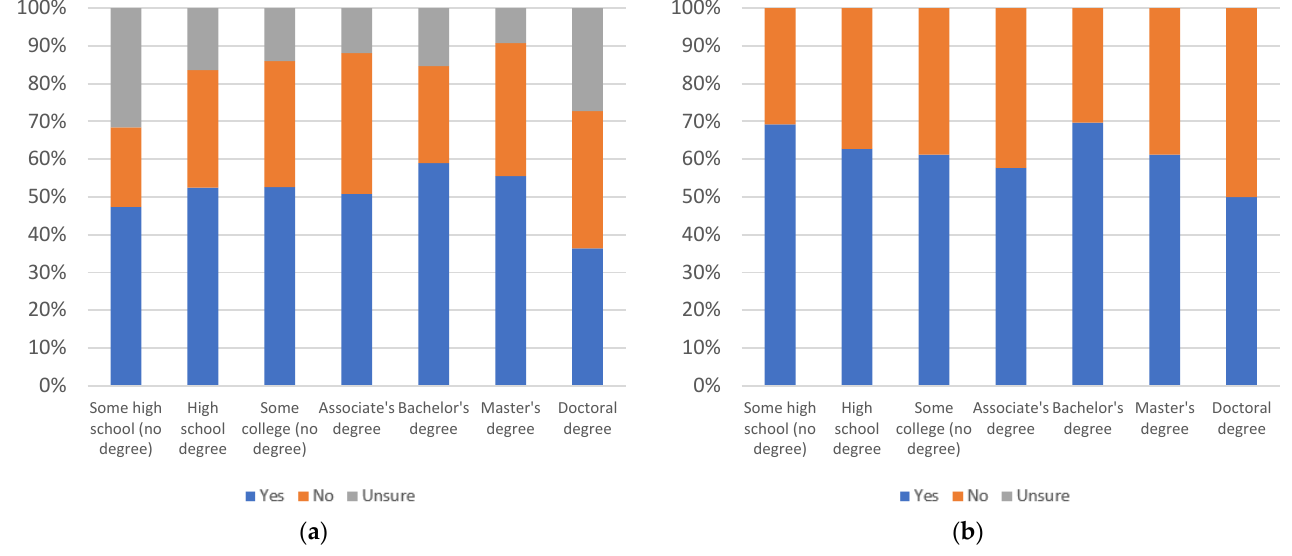
Figure 98. Label trustworthiness judging use, by education level: ( a ) with uncertain respondents (left) and ( b ) without uncertain respondents (right).